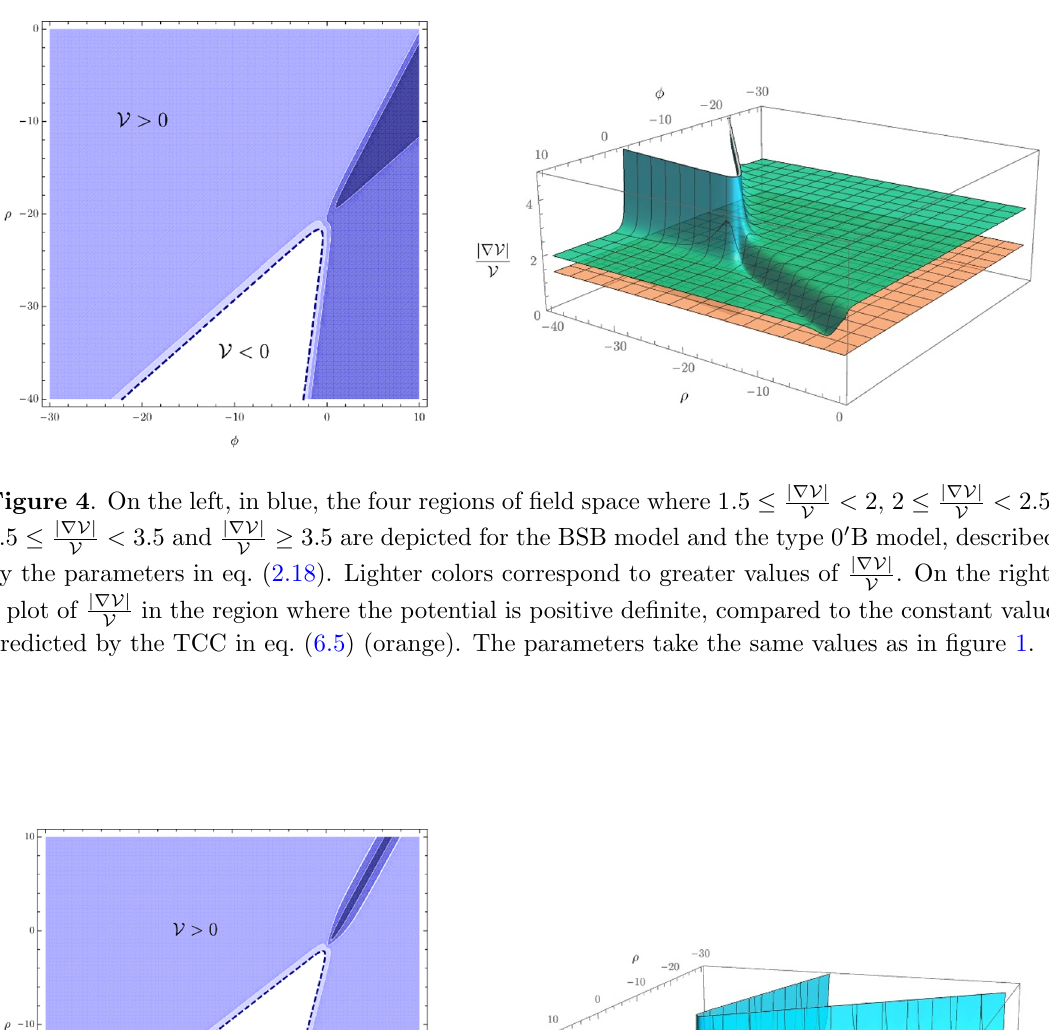
< 2, 2 (cid:20) jrVj V V . On the right, a plot of jrVj in V V